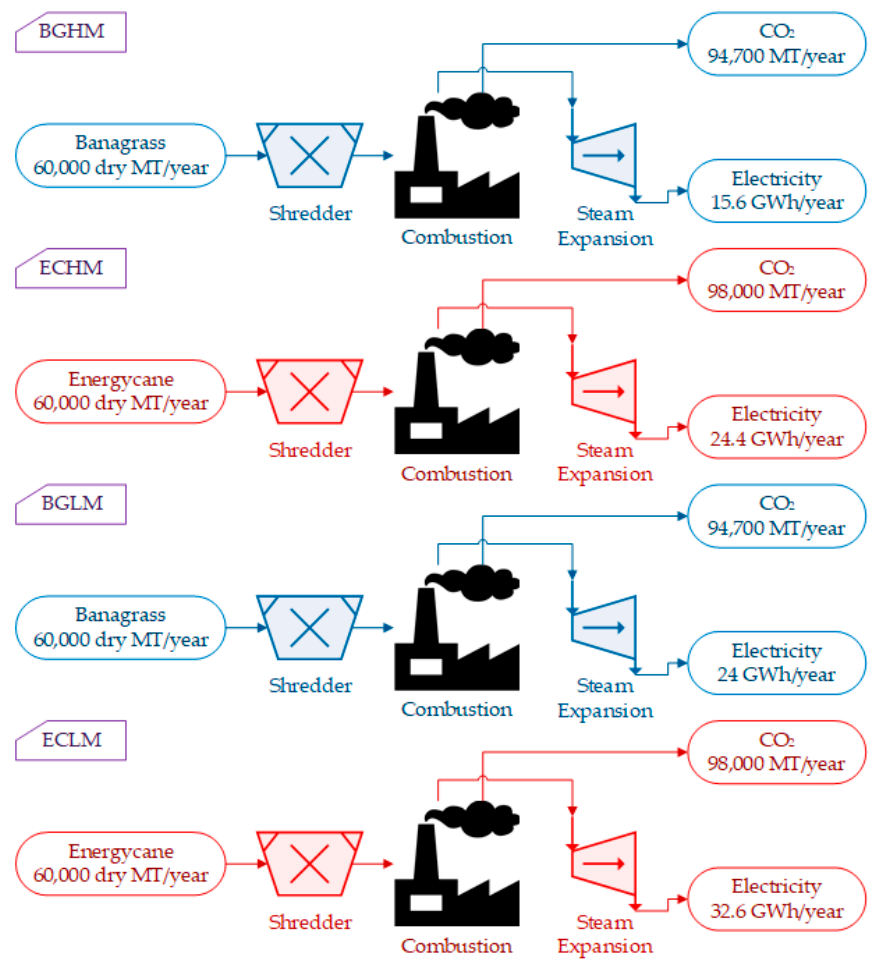
Figure 3. Block flow diagram showing the mass balance for different scenarios. BG and EC refer to banagrass and energycane; HM and LM refer to high moisture and low moisture respectively.